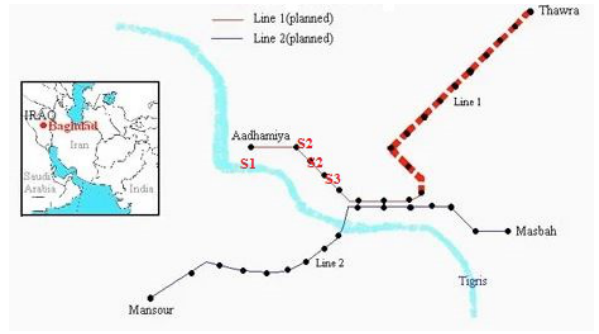
Figure 1: Location of surveyed stations